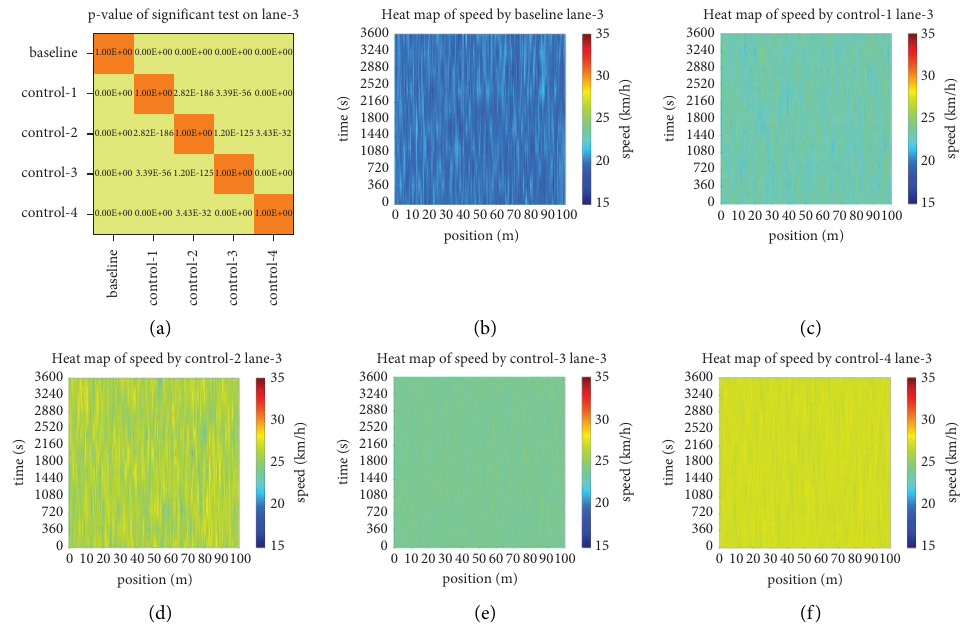
Figure 12: Heatmaps of vehicle speed distributions under diferent control strategies and t -test results in lane-3. (a) T -test p value matrix. (b) Baseline (no controls). (c) Control-1 strategy (channelization left-right). (d) Control-2 strategy (channelization right-left). (e) Control-3 strategy (ramp metering). (f) Control-4 strategy (channelization and ramp metering).